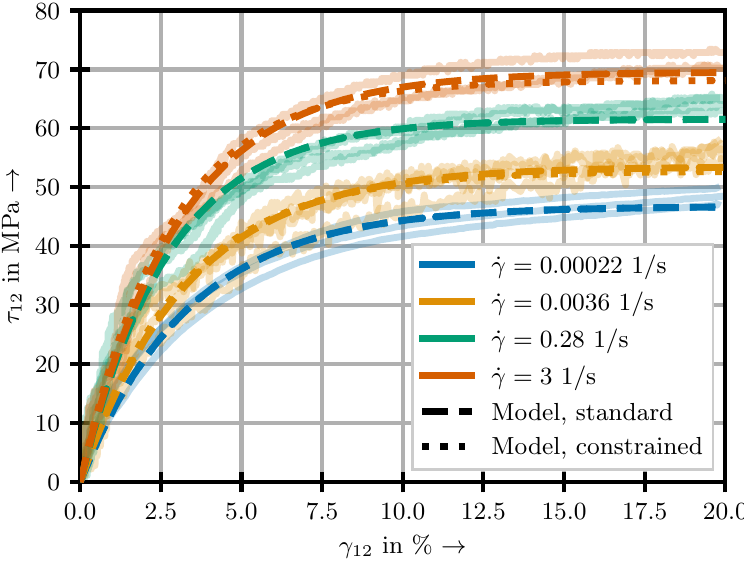
Figure 8. Juxtaposition of experimental results and corresponding model predictions with parameters based on standard and constrained